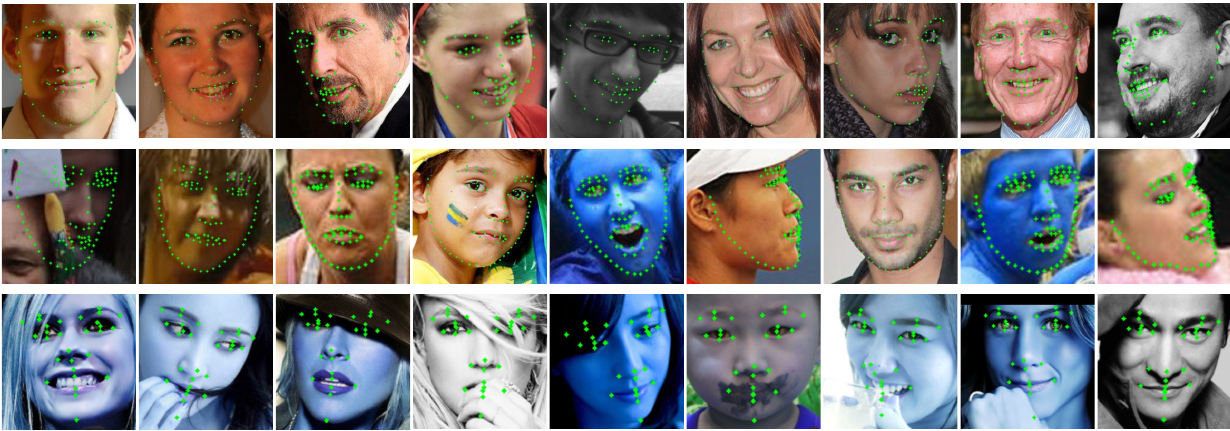
Figure 4. FPS of our method using different batch sizes on 300W.